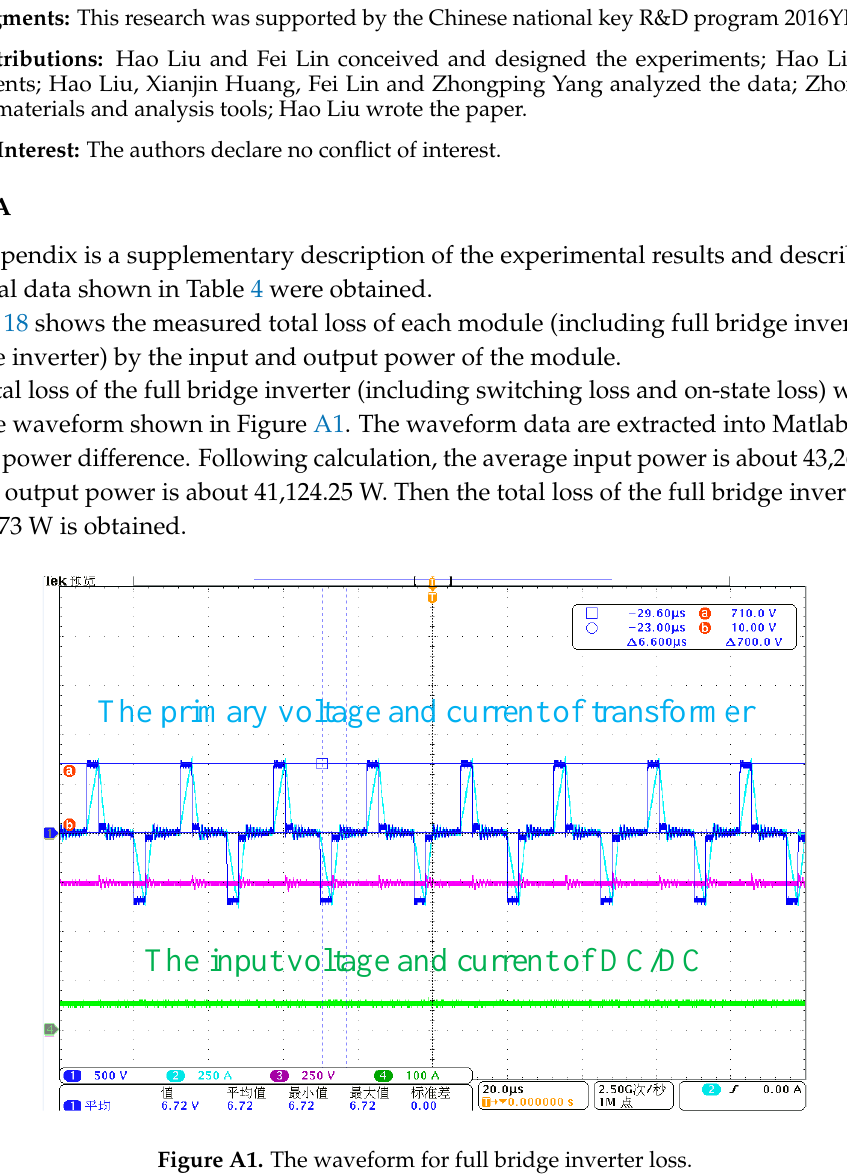
Figure A1. The waveform for full bridge inverter loss.